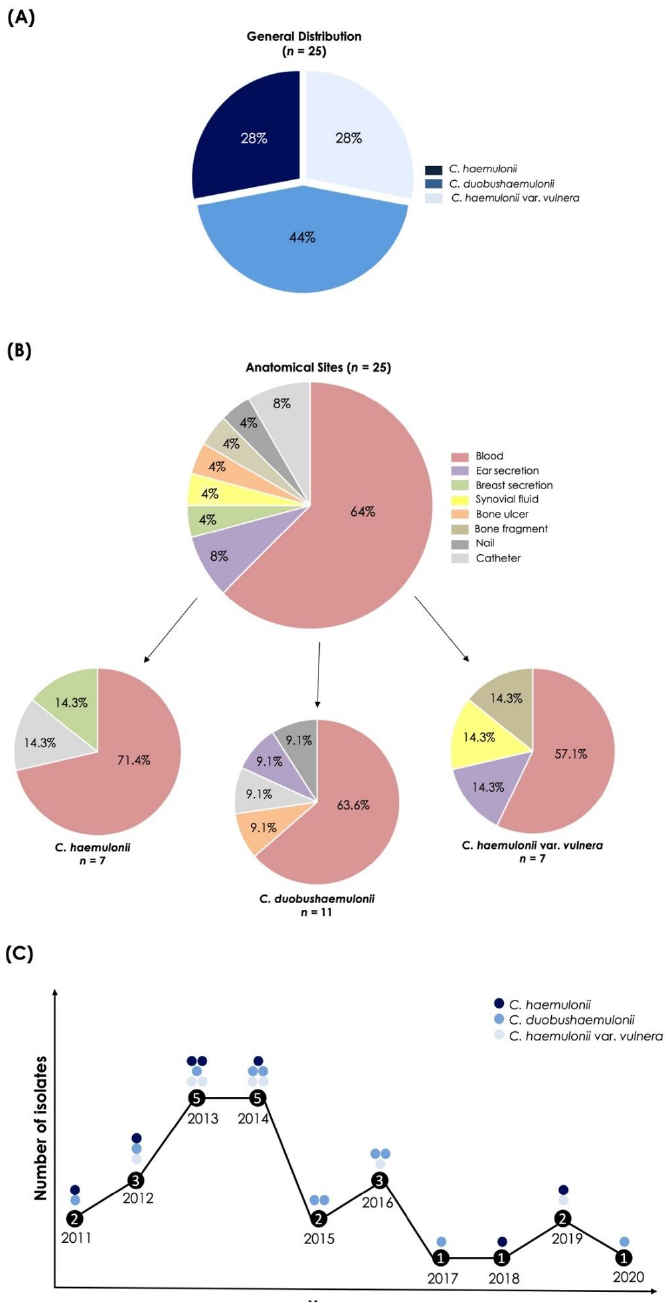
Figure 1. Distribution of species comprising the C. haemulonii complex obtained from Brazilian hos- pitals (Rio de Janeiro State). ( A ) General species distribution considering the total number of clinical